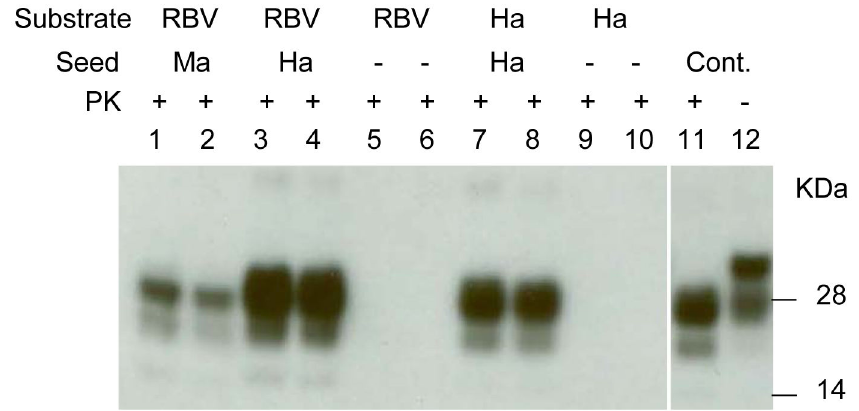
Figure 2. Interspecies PMCA with vCJD macaque brain homogenate and red-backed vole 170N/N as the substrate. Macaque vCJD brain material and hamster 263K scrapie brain material was diluted 10 2 -fold into 10% RBV 170N/N NBH and subjected to 1 round of PMCA (lanes 1-4 respectively). Lanes 5-6 indicate control PMCA samples containing 10% RBV 170N/N NBH substrate only without added seed. Scrapie hamster brain material was diluted 10 2 fold into 10% hamster NBH and subjected to 1 round of PMCA (lanes 7-8). Lanes 9-10 indicate 10% hamster NBH without seed subjected to 1 round of PMCA. Scrapie hamster brain homogenate (1%) was loaded in lanes 11 -12 as a positive control (Cont.). Prior to electrophoresis, samples were digested with PK. The blot was stained with 6D11 antibody. doi: